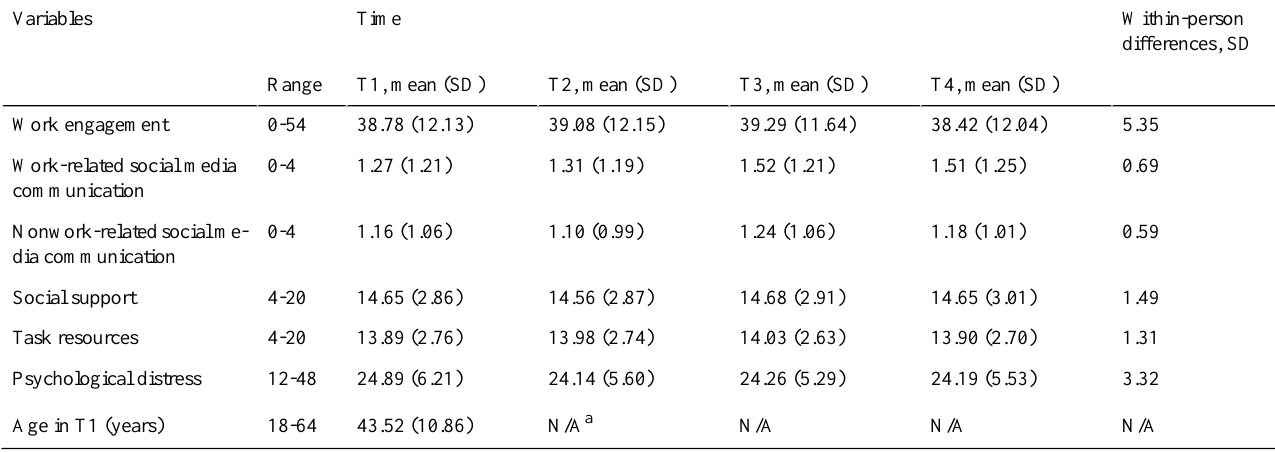
Table 1. Descriptive statistics of the study variables: continuous variables.